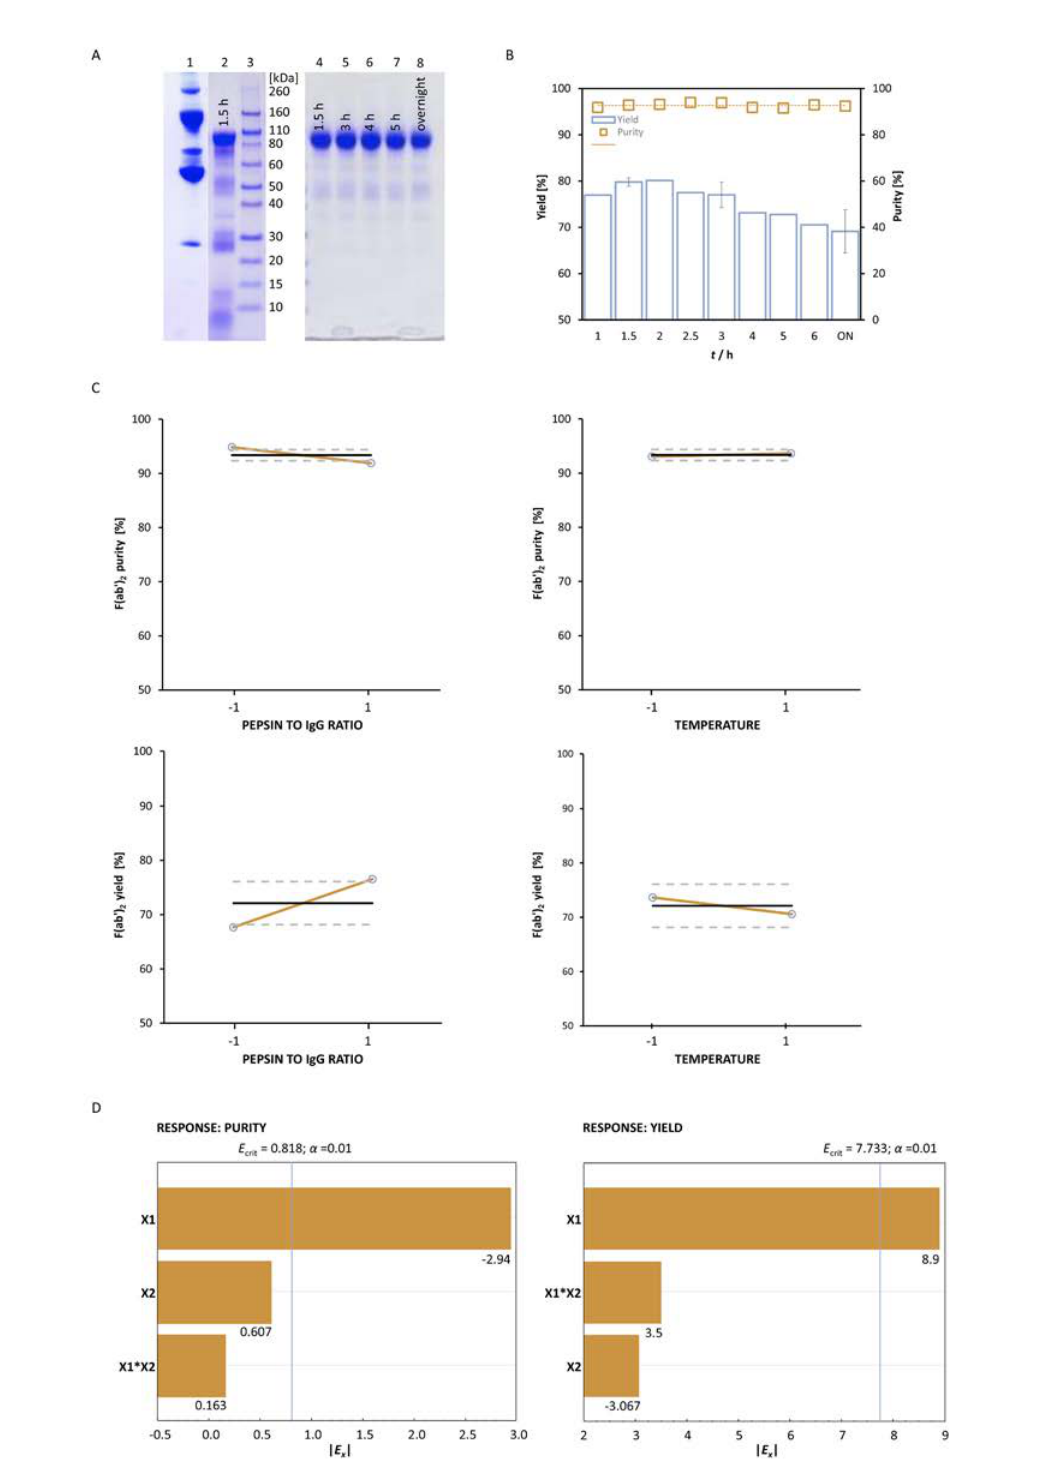
preparation . (A) SDS-PAGE analysis of samples (20 μg) obtained by simultaneous caprylic acid precipitation and pepsin Figure 1. Optimization of F(ab’) 2 digestion of HHP at 37 or 23 °C. Lane 1, HHP; Lane 2, sample obtained at 37 °C with 1.5 h-long incubation; Lane 3, molecular weight standards; lanes 4-8, samples obtained at 23 °C with duration of incubation as indicated. Staining was performed with CBB R250. (B) Time-course of SEC-determined yields and purities of F(ab’) preparations obtained by precipitation and digestion co-performance at 23 °C following diafiltration on a 50 kDa membrane. Results are given 2 as mean +/- standard error. (C) Optimization of precipitation and digestion co-performance step with respect to the pepsin-to-IgG ratio and temperature studied according to full factorial experimental design. Mean yield (ο) of active drug obtained post-diafiltrationally at higher and lower level of each experimental factor (X1 – pepsin-to-IgG ratio, X2 – temperature) in comparison to mean value (full line) and 95% confidence interval (dashed lines) from the overall set of experiments. (D) Pareto plot of effect estimates. The absolute value of the main effect for each factor (| E |) is presented in horizontal columns. The critical effect x values for significance level of α = 0.01 is marked by a vertical